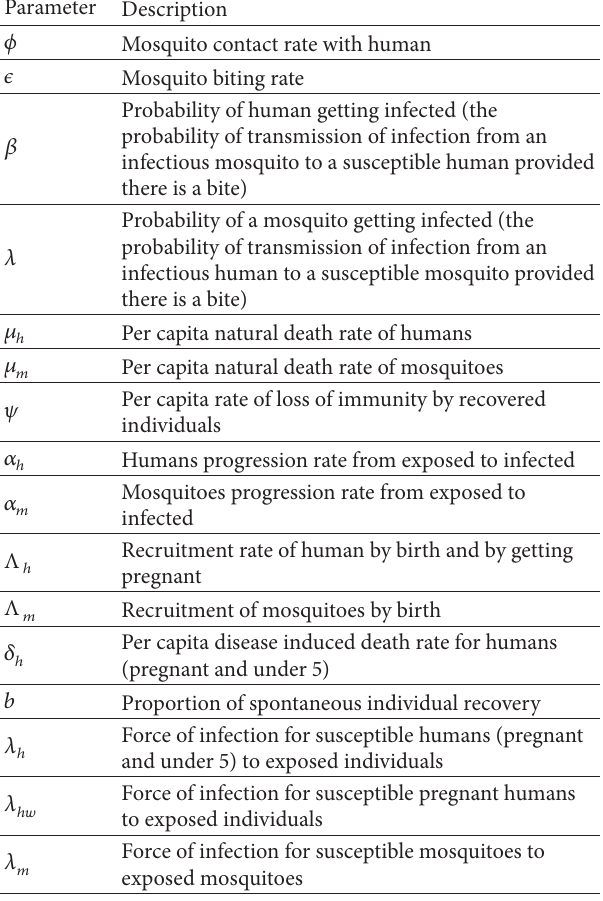
Table 2: Description of parameter variables of the malaria model. Parameter